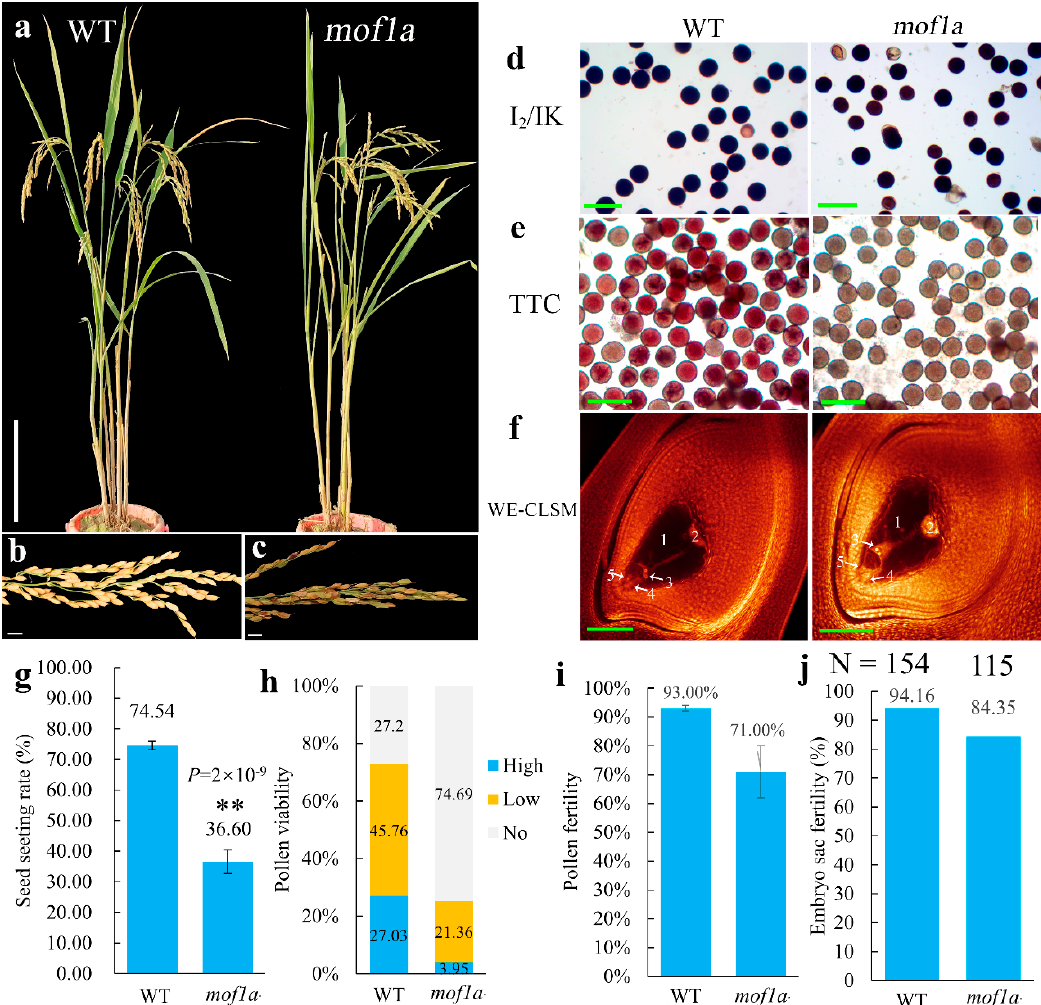
Figure 3. Morphological and cytological identification of MOF1a . ( a ) The plant type of H1 (WT) and mof1a . Bars = 20 cm. ( b , c ) Mature panicles of WT/ mof1a . Bars = 1 cm. ( d , e ) I 2 /IK staining and TTC staining of WT/ mof1a pollen grains at mature stage. ( f ) Mature embryo sac of WT/ mof1a . 1, central cell; 2, antipodal cells; 3, polar nuclei; 4, synergid; 5, egg cell. Green bars = 100 µm. ( g ) Seed setting of WT and mof1a . Five plants of WT and mof1a were studied, respectively. P value was calculated using two-tailed Student’s t -test. “**” indicates that P value was less than 0.01. ( h , i ) Pollen viability (TTC) and pollen fertility (I 2 /IK) of WT and mof1a based on three independent biological samples. ( j ) The mature embryo sacs fertility of WT and mof1a . n , numbers of embryo sacs observed. The error bars indicate the ±SE.